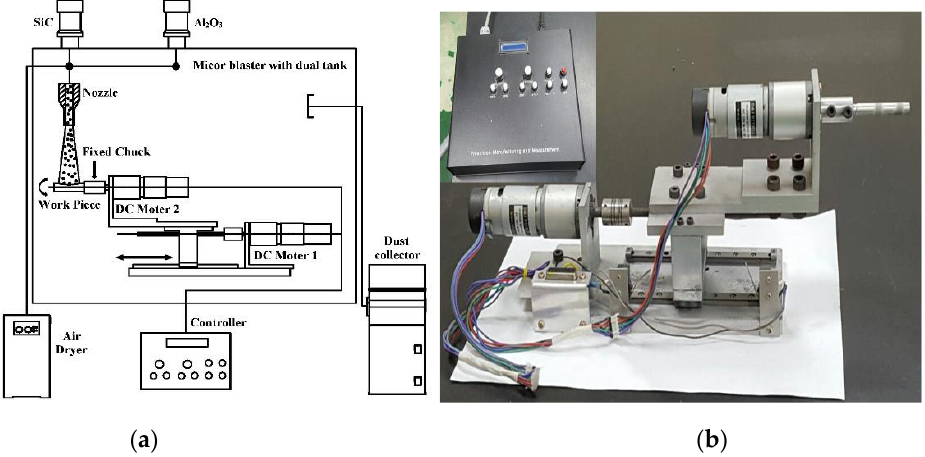
Figure 3. Schematic diagram of ( a ) blasting movement system, ( b ) rotating and straight motion jig.